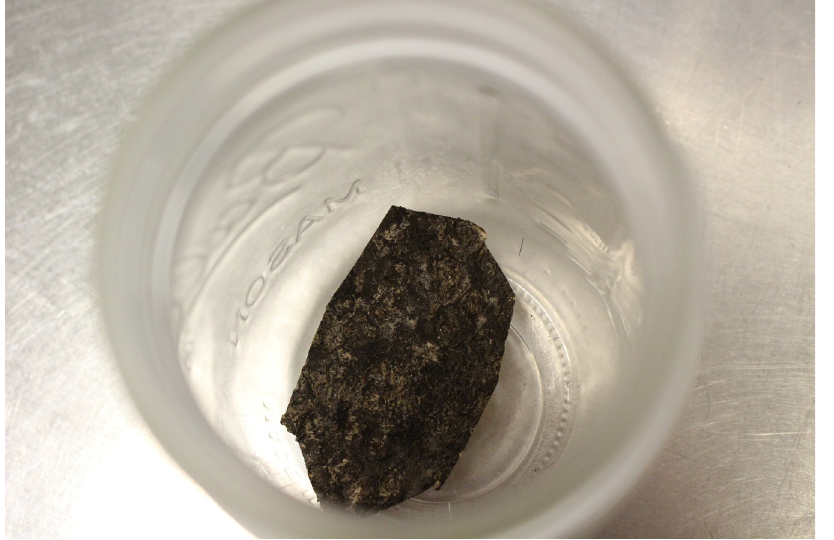
Fig 5. Picture of one of the control barks from Ailanthus altissima .